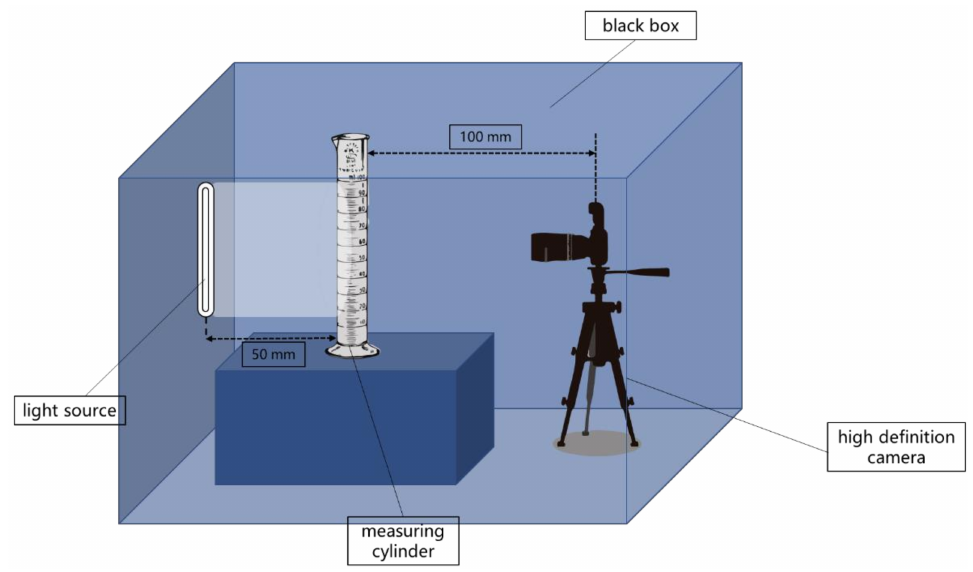
Figure 3. Schematic diagram of experiment